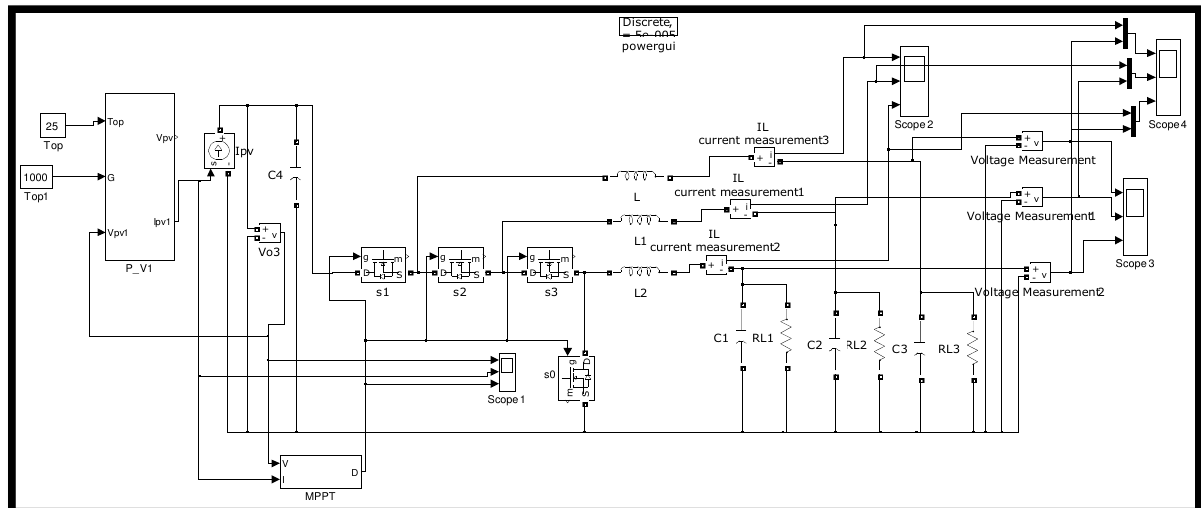
Fig. 13. Model of solar PV emulator utilizing buck converter